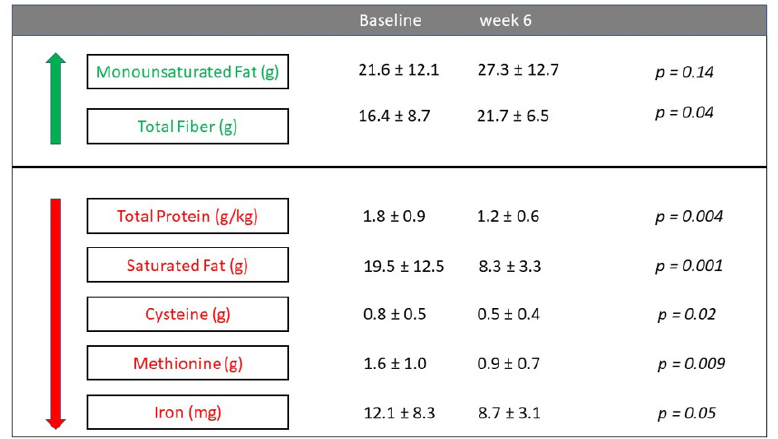
Figure 4. Dietary intake of macronutrients and micronutrient targets for UCED at baseline and after diet treatment: total protein (g/kg, n = 20), saturated fat (g, n = 19), monounsaturated fat (g, n = 19), fiber (g, n = 20), cysteine (g, n = 15), methionine (g, n = 15), and iron (mg, n = 19).